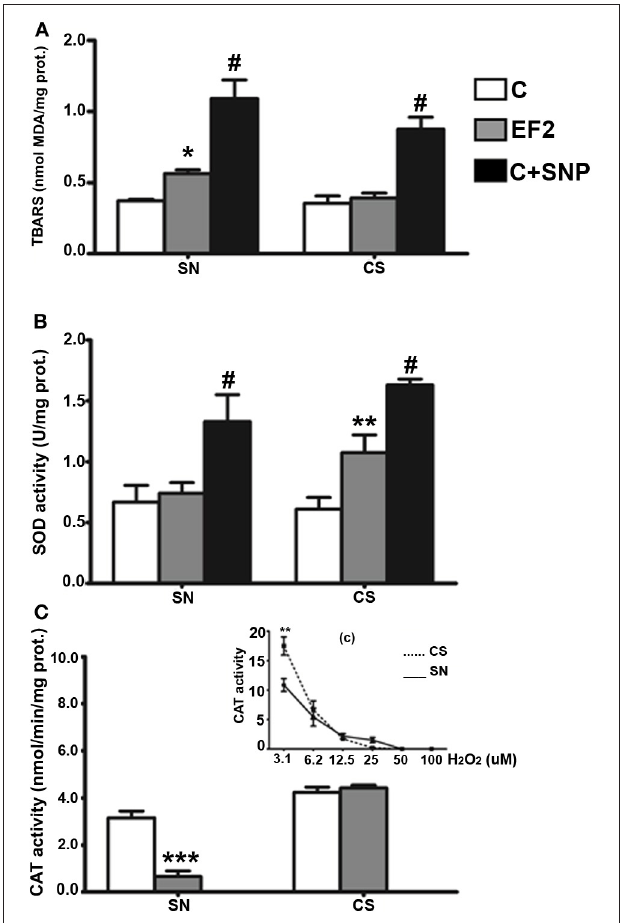
FIGURE 2 | Thiobarbituric acid-reactant substances (TBARS) levels (A), total superoxide dismutase (t-SOD) activities (B), and catalase (CAT) activities (C) in the pool of Substantia Nigra and Corpus Striatum from young rats fed an essential fatty acid restricted diet over two generations and respective controls ( n = 12 per group). ∗ P < 0 . 05; ∗∗ P < 0 . 001 compared to control group. Treatment of control homogenates with sodium nitroprusside (SNP) was used as positive control for TBARS and t-SOD in all the experiments. The insert (c) in the panel (C) shows the H 2 O 2 concentration-dependentmanner of the CAT activity in the SN and CS control homogenatesobtained as positive controls. # P < 0 . 0001 compared to control or EF2